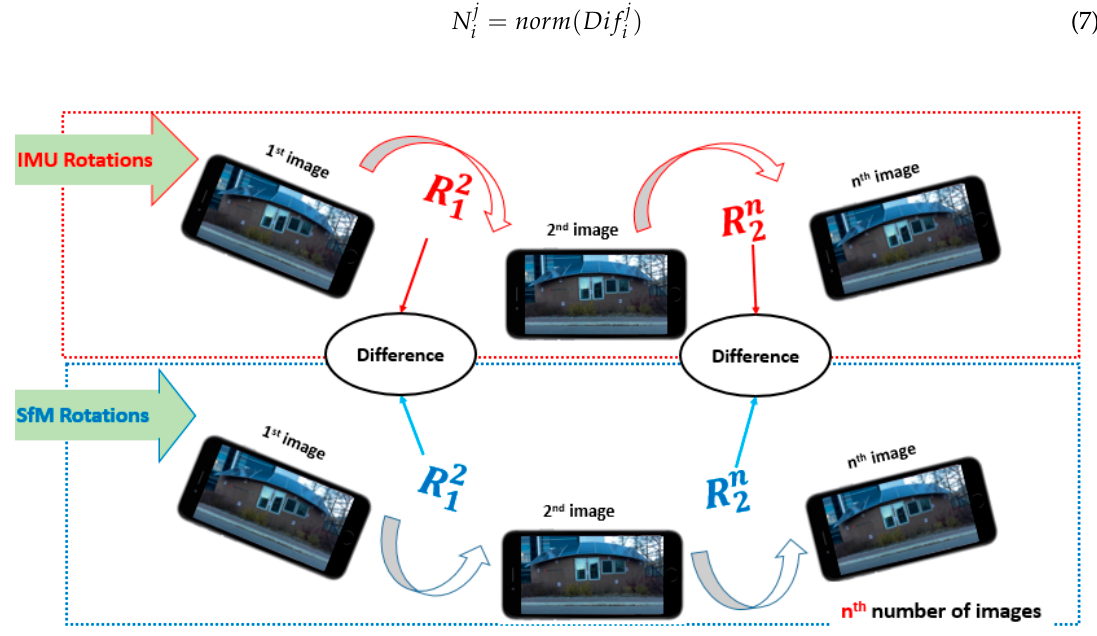
Figure 6. The difference between each corresponding relative rotation.